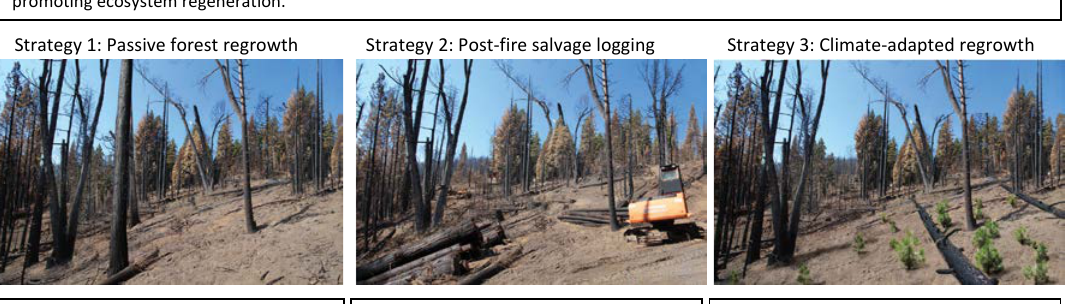
Strategy 1: Passive forest regrowth Strategy 2: Post-fire salvage logging Strategy 3: Climate-adapted